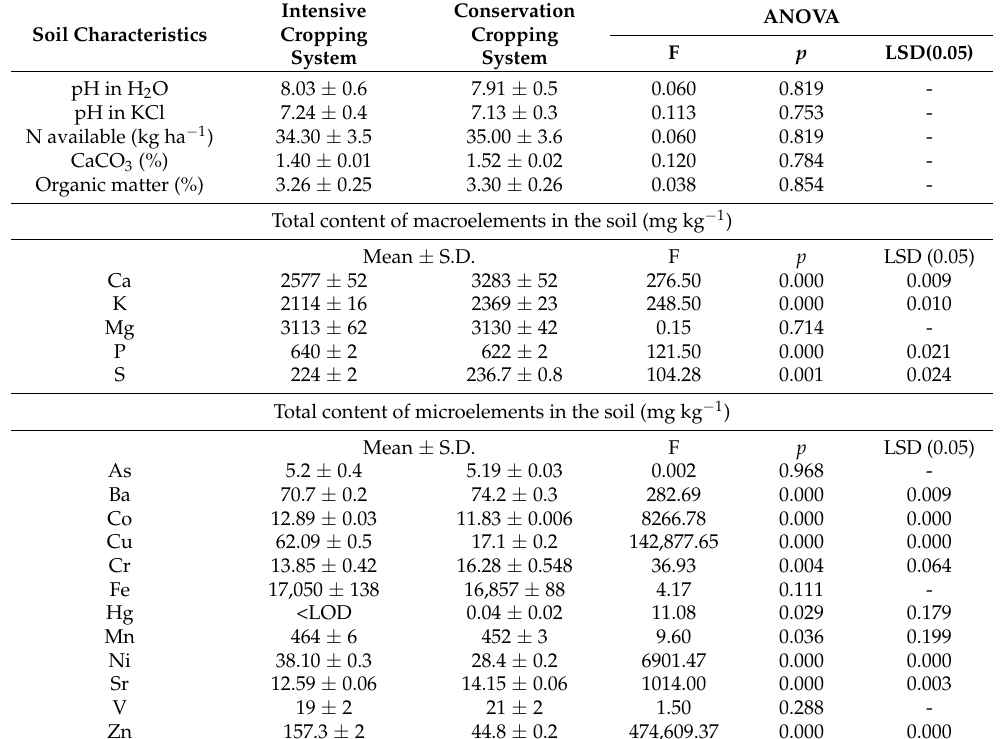
Table 1. Soil characteristics and elemental composition of the soil under ICS and CCS cropping